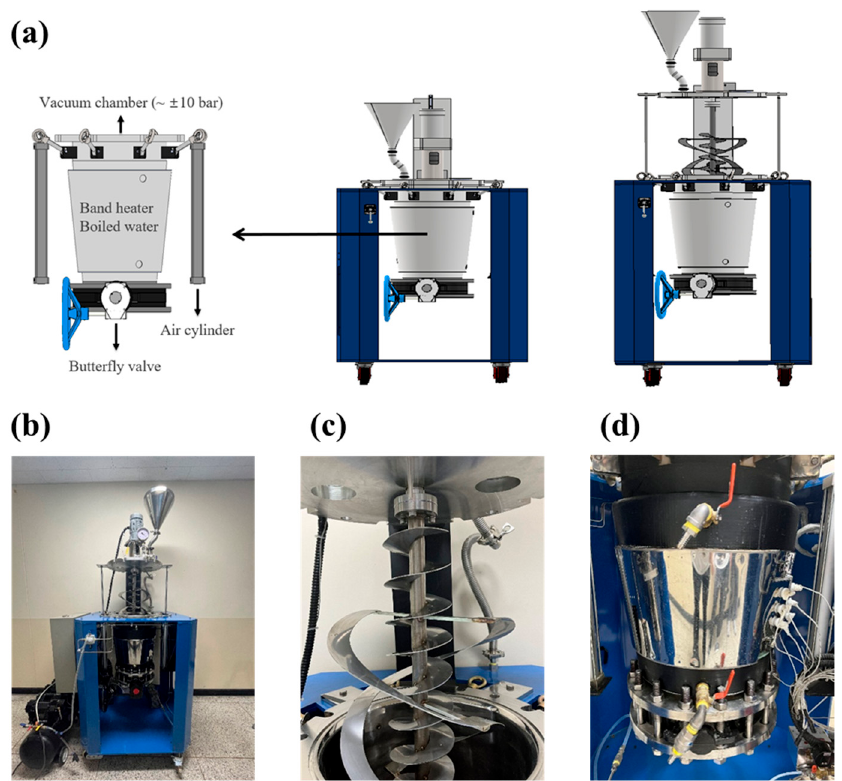
Figure 6. A schematic diagram of the developed vacuum-steam heating system: ( a ) a 3D schematic, ( b ) a front view, ( c ) a conical ribbon blade, and ( d ) a vacuum chamber.